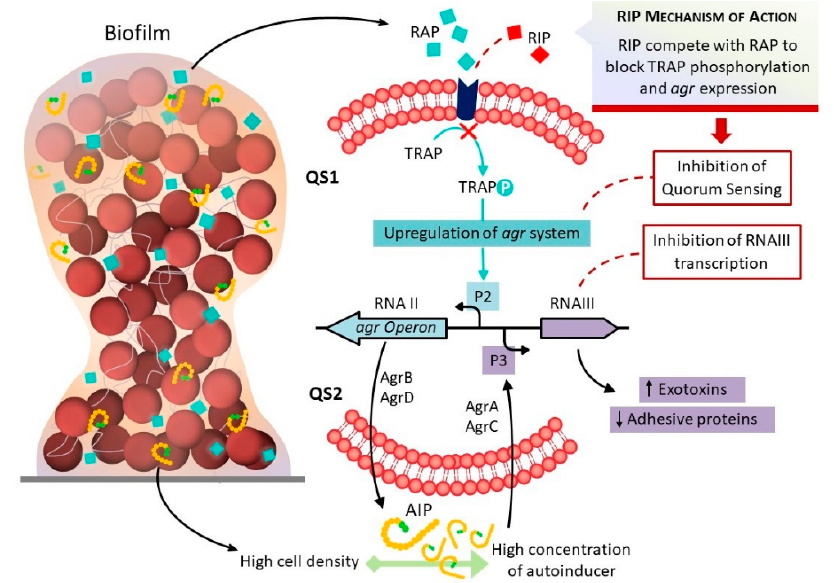
Figure 1. Schematic representation of agr control in staphylococci. As the bacteria multiply, RAP reaches a concentration threshold, inducing the phosphorylation of TRAP that triggers a poorly known mechanism for the synthesis of QSII, which consists of the products of the agr system. The agr system is composed of two divergent transcripts, RNAII and RNAIII. RNAII encodes AgrA, AgrC, AgrD, and AgrB. AgrD produces autoinducing peptide (AIP) that is processed by AgrB maturation and export. At a certain threshold concentration, AIP induces the phosphorylation of its receptor AgrC, and phosphorylated AgrA activates transcription from the P3 promoter, leading to the production of RNAIII. In addition to the presence of the RAP-TRAP system, there is also an antagonist, RIP, that can inhibit RNAIII activity. RIP competes with RAP to block TRAP phosphorylation, shutting down QS1 and agr